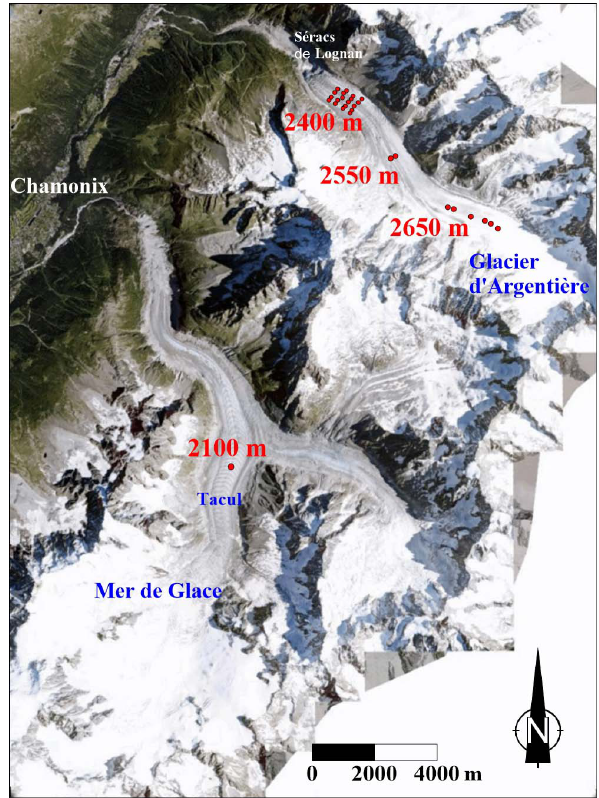
Figure 1. Map of the Argentière and Mer de Glace glaciers. The red dots on the Argentière Glacier are the ablation stakes used in this study for annual surface mass balance and ice flow velocity mea- surements in three regions of the glacier (at approximately 2400, 2550 and 2700ma.s.l.). Aerial photo from the French National Ge- ographical Institute, 2015 (https://www.geoportail.gouv.fr/, last ac- cess: 25 February